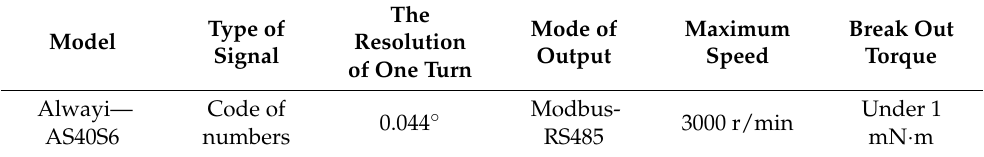
Table 1. Specific parameters of the absolute encoder.